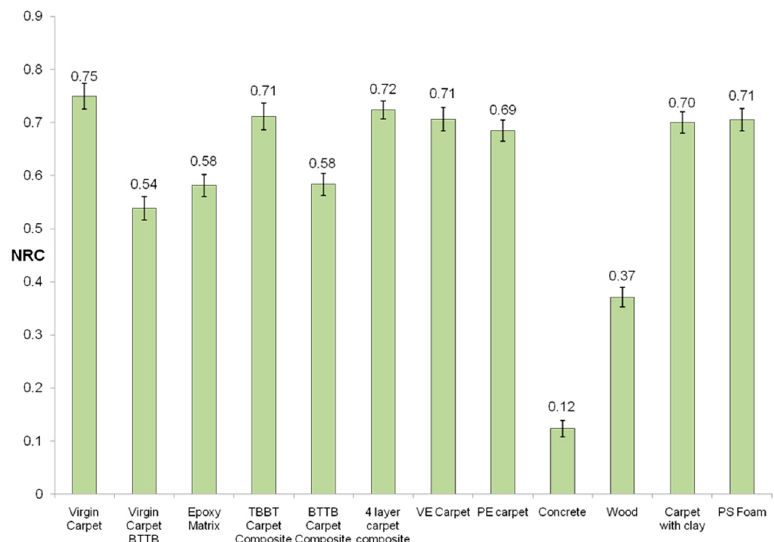
Figure 9. Noise reduction coefficients of all the materials calculated at the third-octave band range of frequencies using ASTM C 384-04.